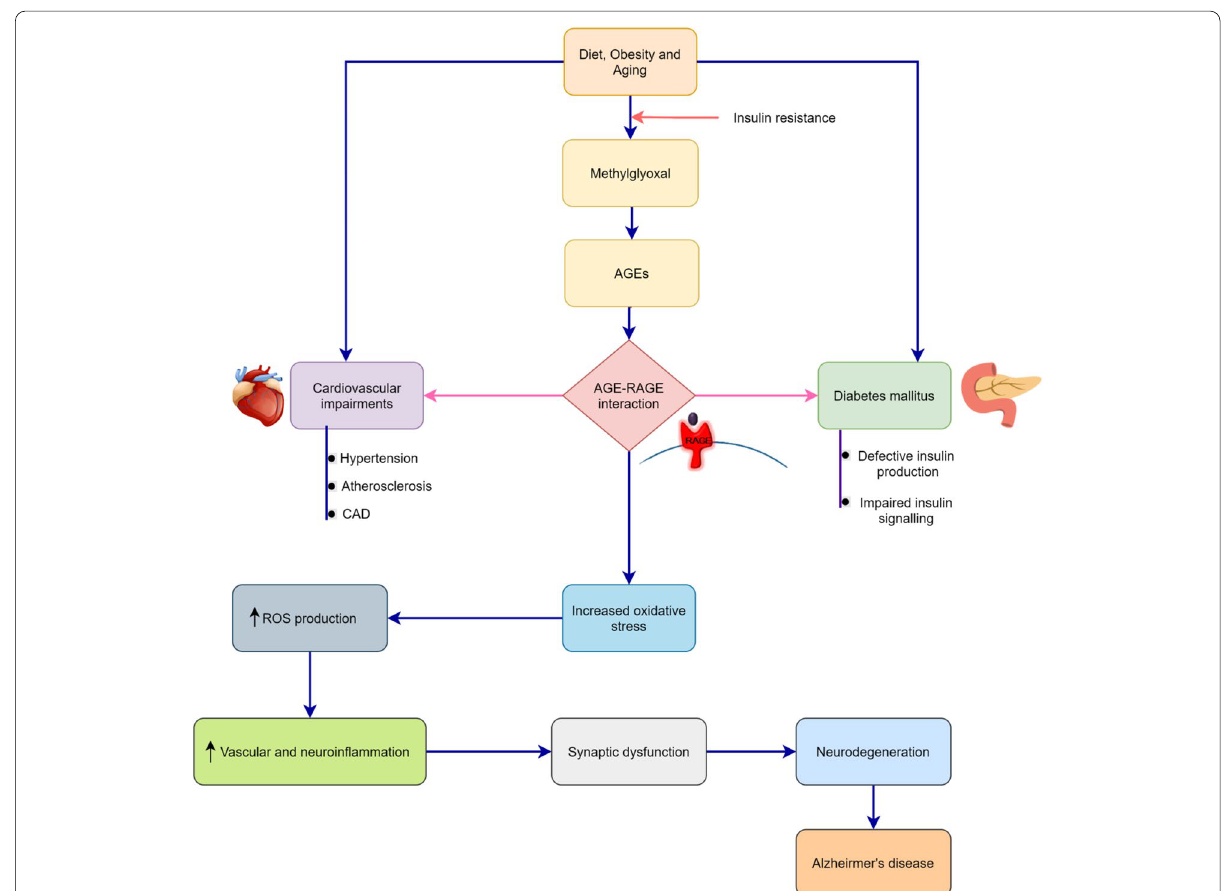
Fig. 1 The overview of the relationships among the Alzheimer’s disease, diabetes mellitus, and cardiovascular